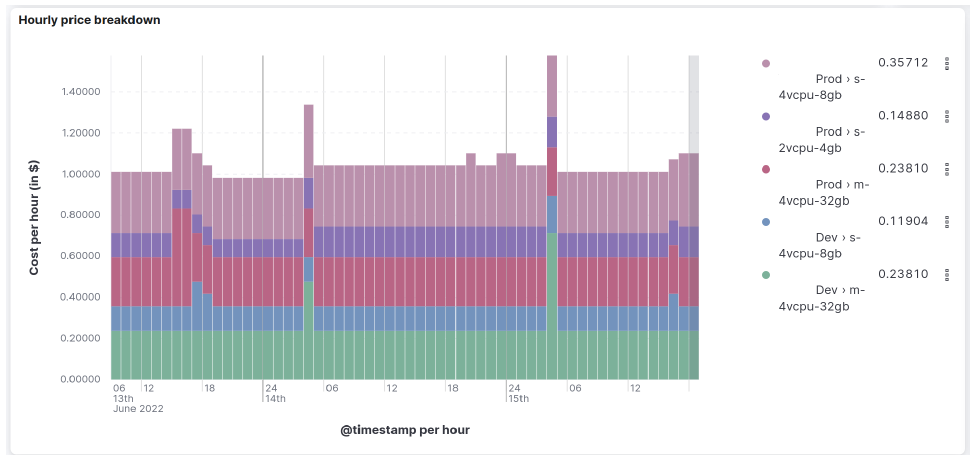
Figure 6. Hourly cost breakdown across both environments.